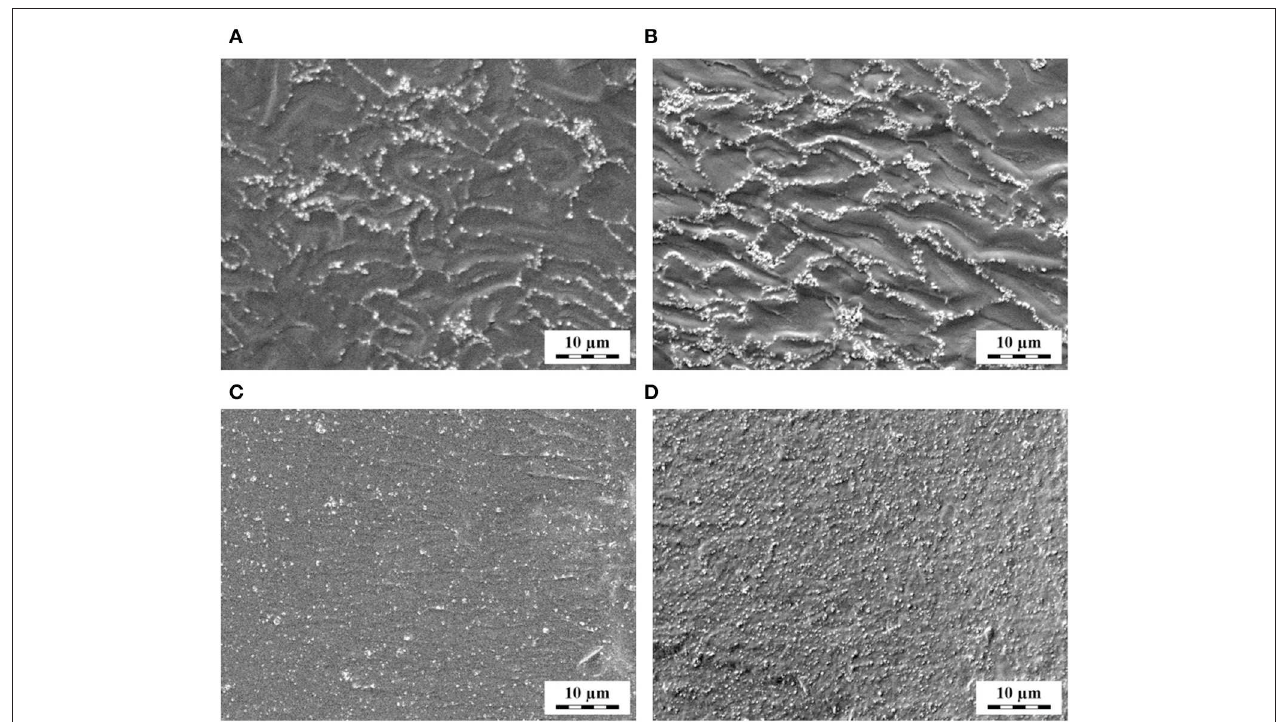
FIGURE 2 | SEM/SE micrographs showing TPS/TiO 2 composites with (A,C) 10% and (B,D) 20% of the filler: (A,B) after solution casting and (C,D) after solution casting and melt mixing.